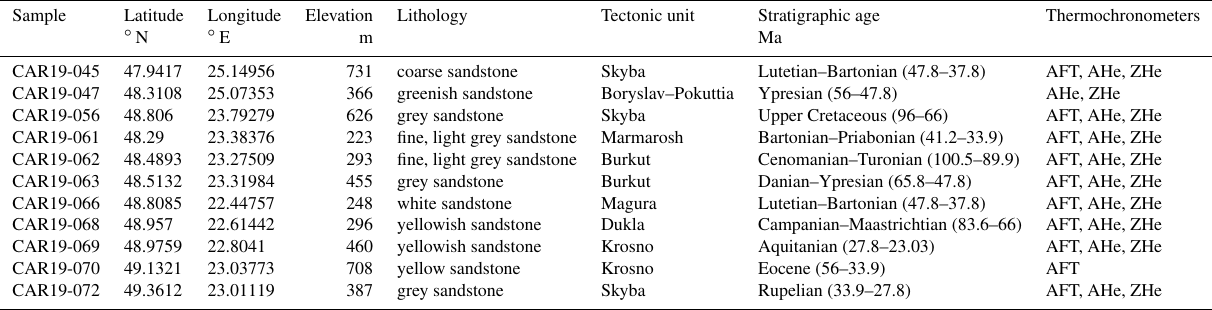
Table 1. Sample locations and characteristics.